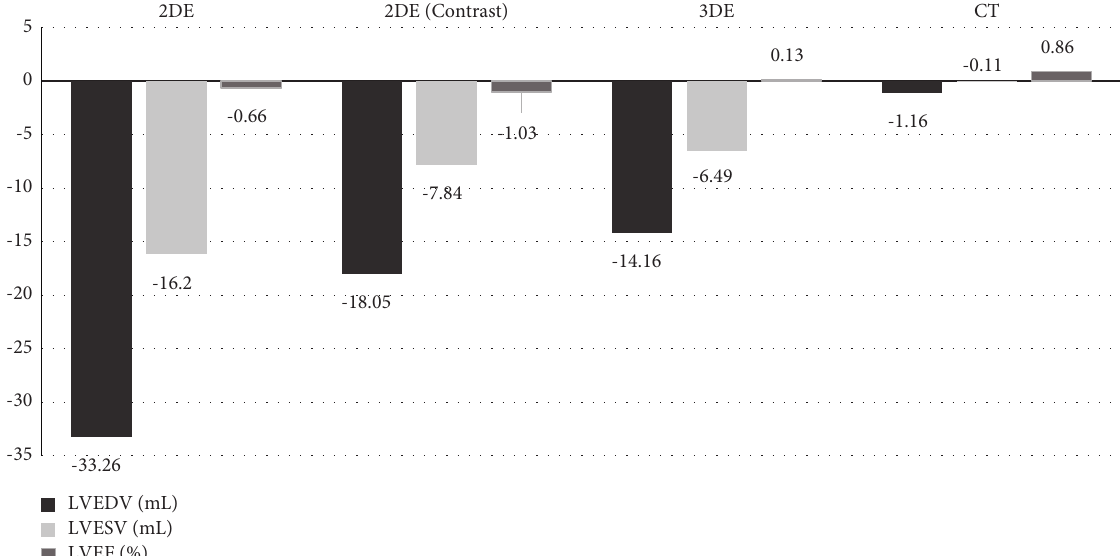
Figure 2: Mean bias associated with LV quantification by multimodality imaging compared to reference CMR using data derived from Rigolli et al.